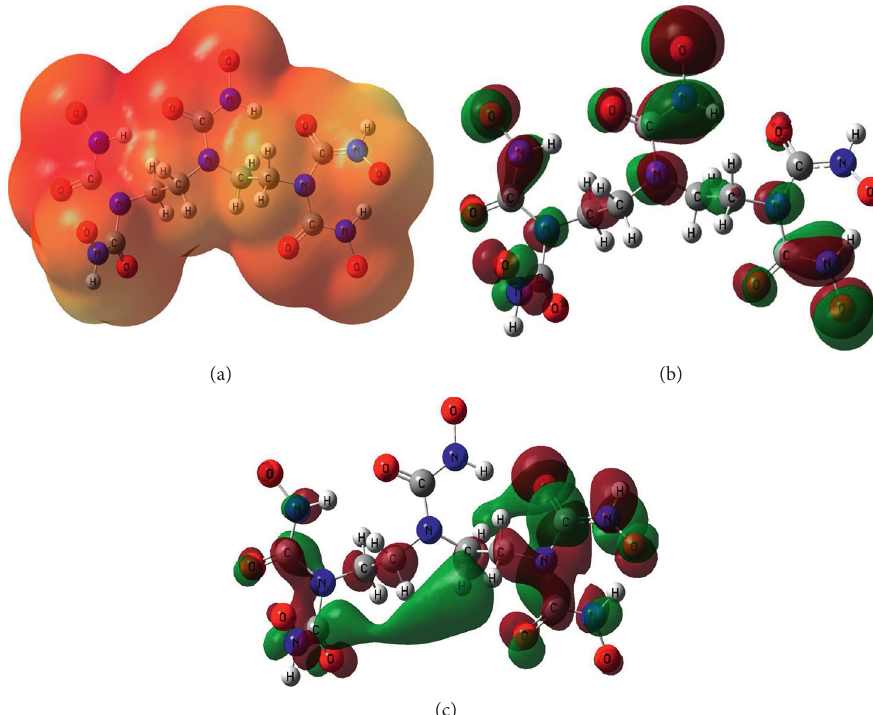
Figure 4: The (a) ESP, (b) HOMO, and (c) LUMO maps of